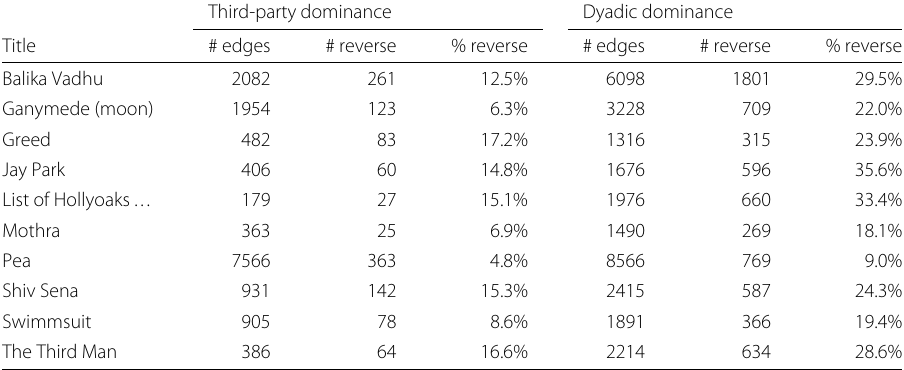
Table 12 For the ten analyzed articles and the two ways to derive a hierarchy (third-party induced dominance and dyadically induced dominance): number of edges, number of reverse edges (i. e., those that point in the wrong direction, i. e., from lower to higher), and percentage of reverse edges Third-party dominance Dyadic